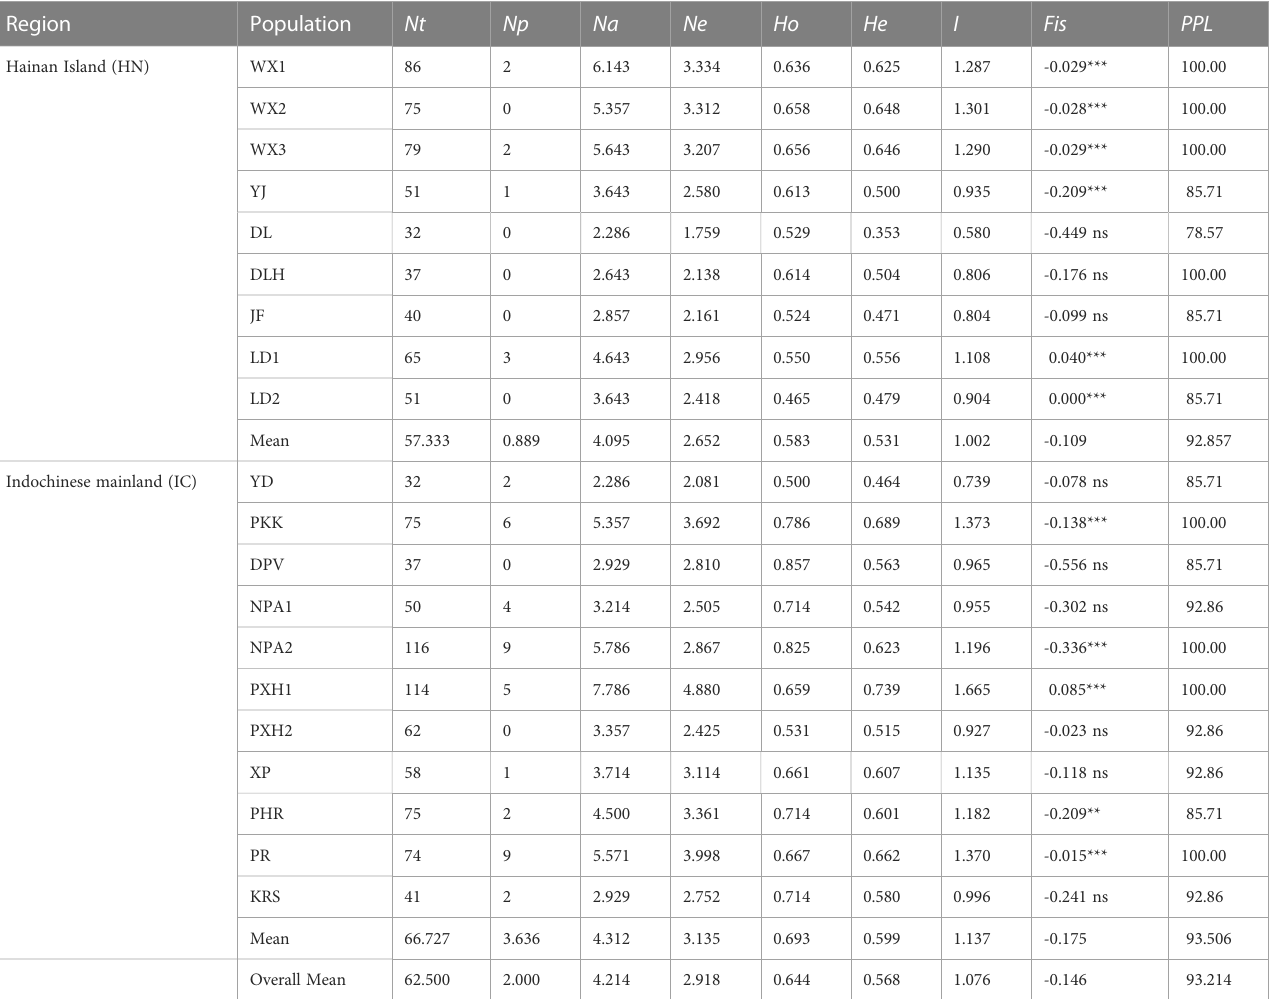
TABLE 3 Genetic diversity metrics by population.